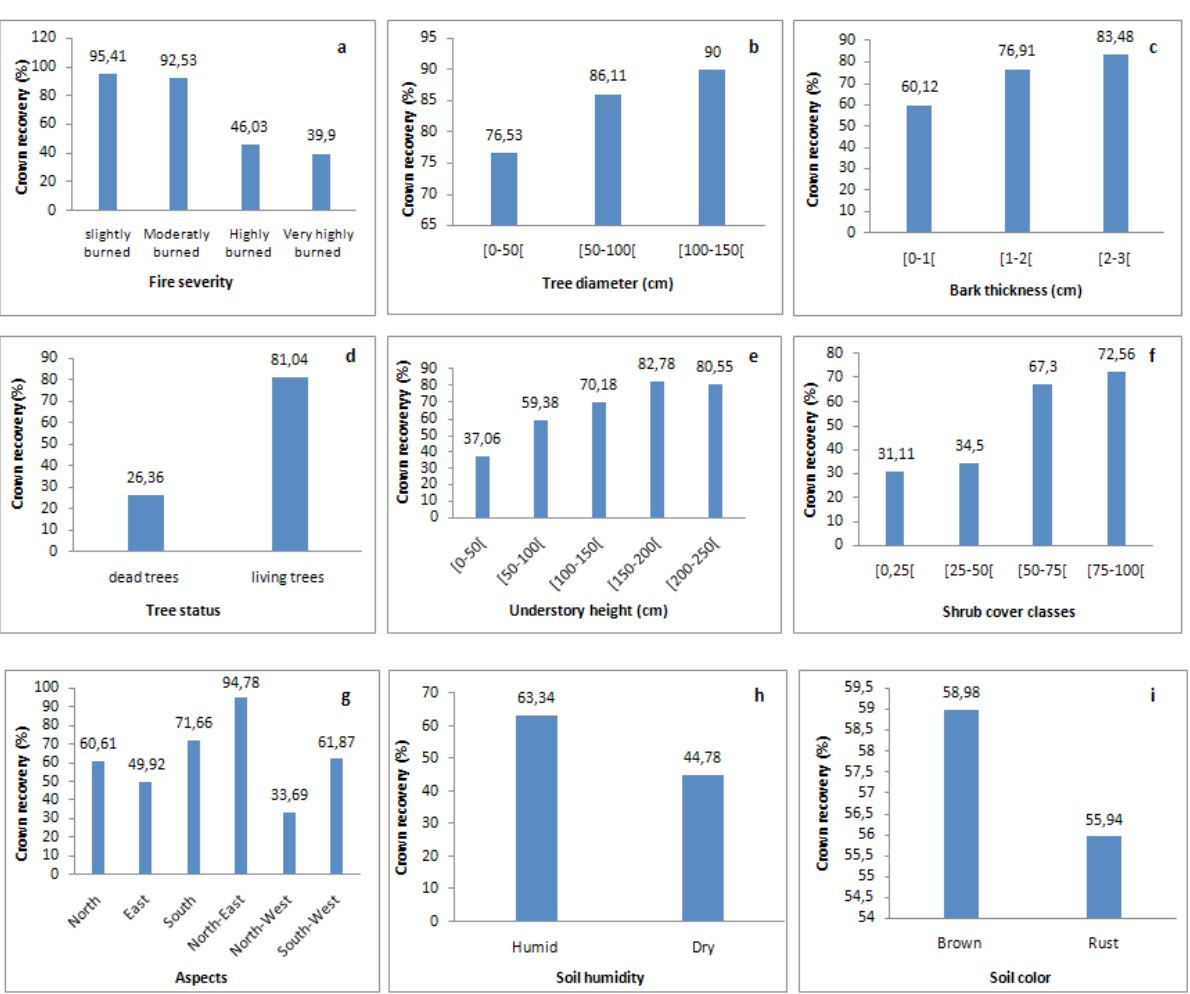
Figure 4. Ordination biplot (RDA) of cork oak trees Figure 5. Ordination biplot (RDA) of cork oak trees and individual tree variables: (TR: tree recovery, and plot environmental variables: (TR: tree recovery, NbrR: number of resprouts, HbR: height of the biggest NbrR: number of resprouts, HbR: height of the biggest resprout, FDT: fire severity, Diam: tree diameter resprout, UnH: Understory height, Ele: Elevation, and Stat: tree Status). SC: Soil color and SH: Soil humidity).